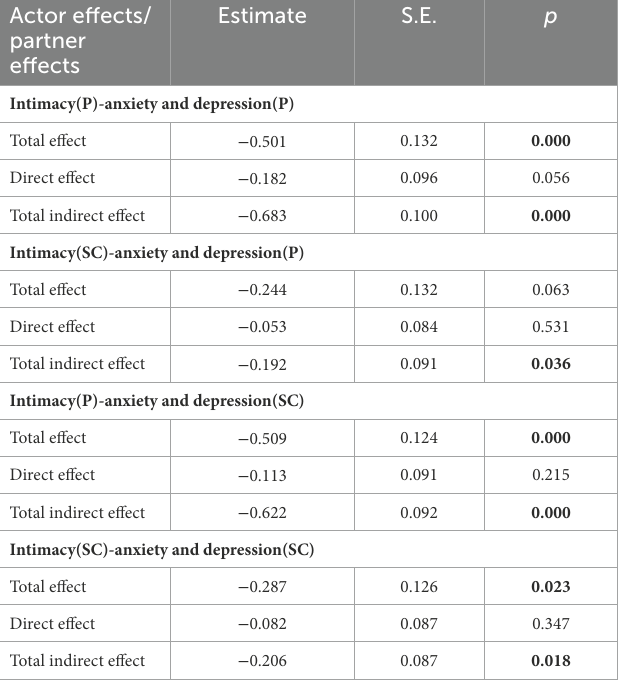
TABLE 4 The direct, indirect, and total indirect effects for pancreatic cancer and spousal caregivers in the APIMeM. Actor effects/ partner